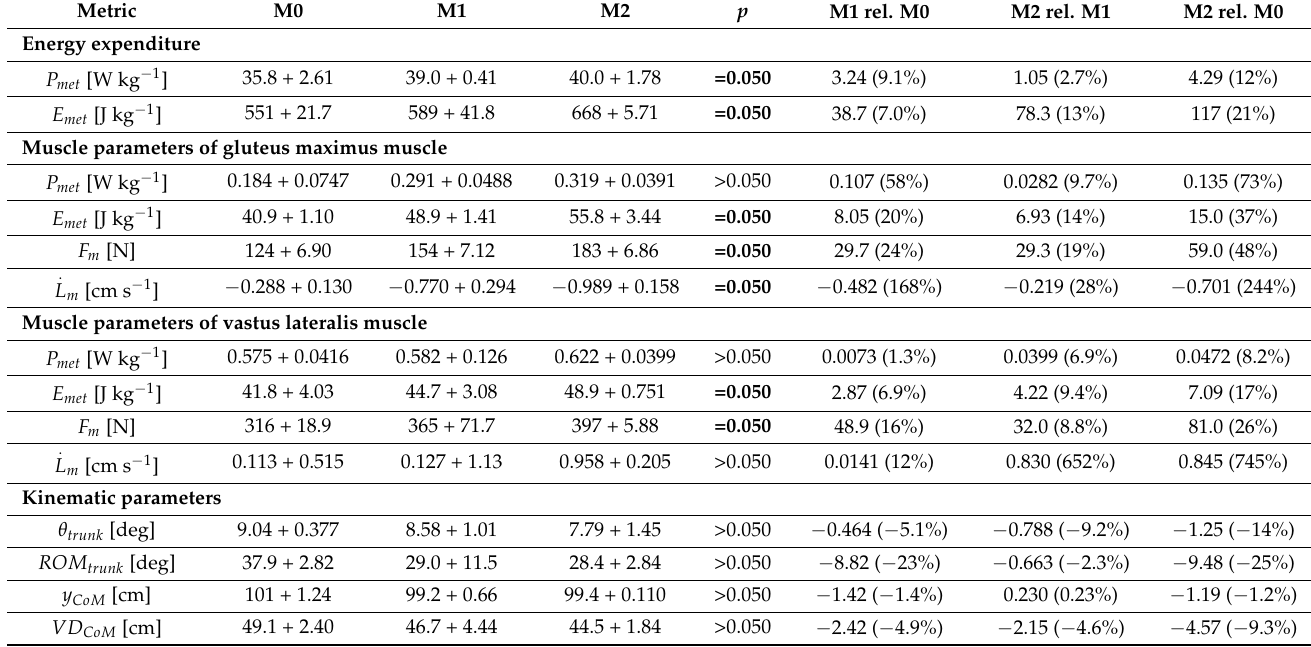
Table 3. Energy expenditure, muscle parameters, and kinematic parameters for three loading conditions of one subject ( n = 1), presented as median + range, ANOVA test results (significant results are in bold), and the differences between loading ‘conditions.